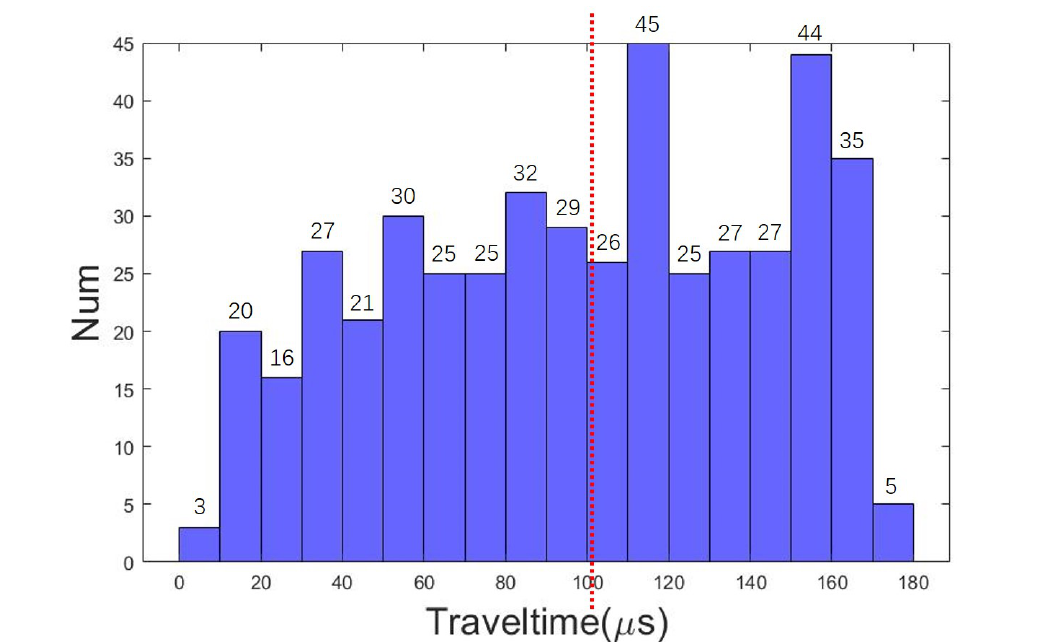
Figure 4. The distribution of 462 traveltime data. Maximum traveltime data is less than 180 µ s. The red line marks the position of the median, which is 101.58 µ